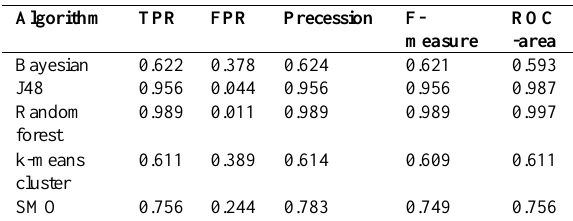
Table 6. Performance parameters measure (weighted average value) of different algorithms for surface dataset.